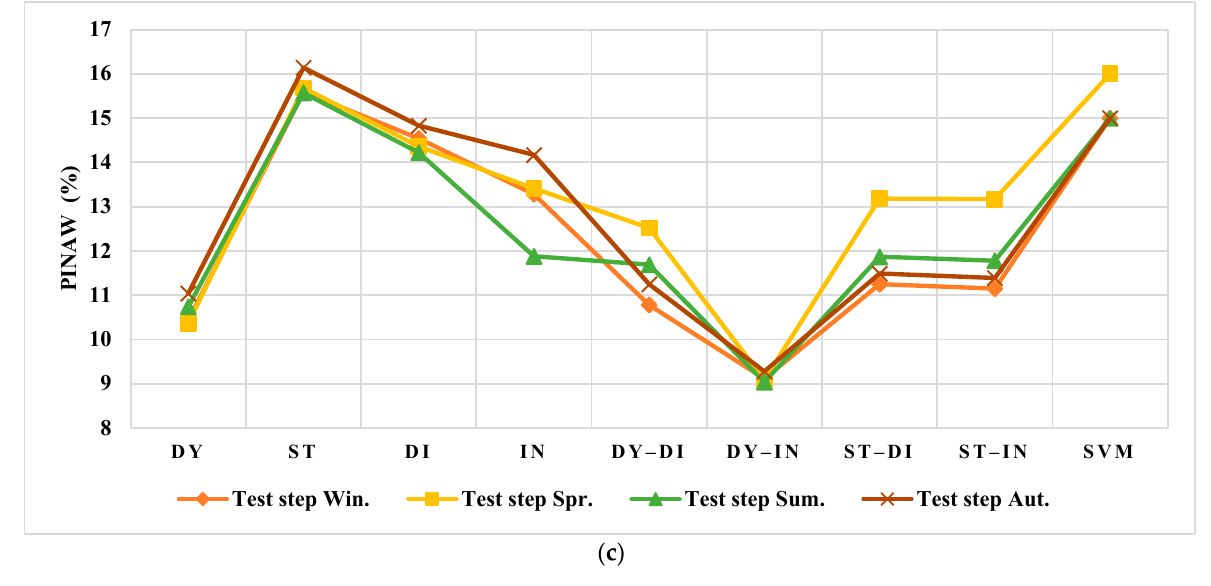
Figure 14. The results of PINAW (%) for Spain: ( a ) Main Component in training step, ( b ) Harmonic Component in training step, ( c ) Test step.